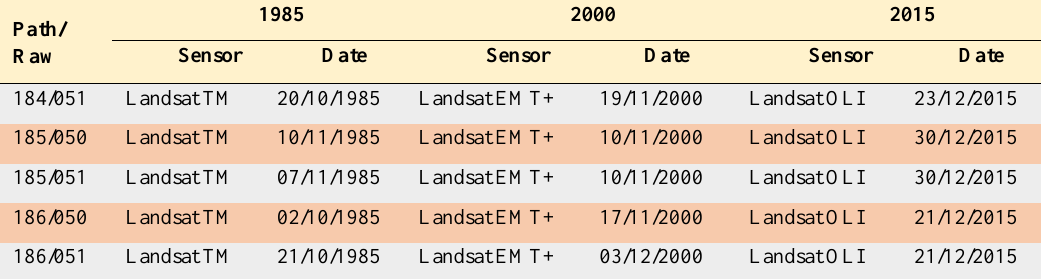
Table 1. The 1985, 2000, 2015 Landsat images with their path, rows and acquisition dates Path/